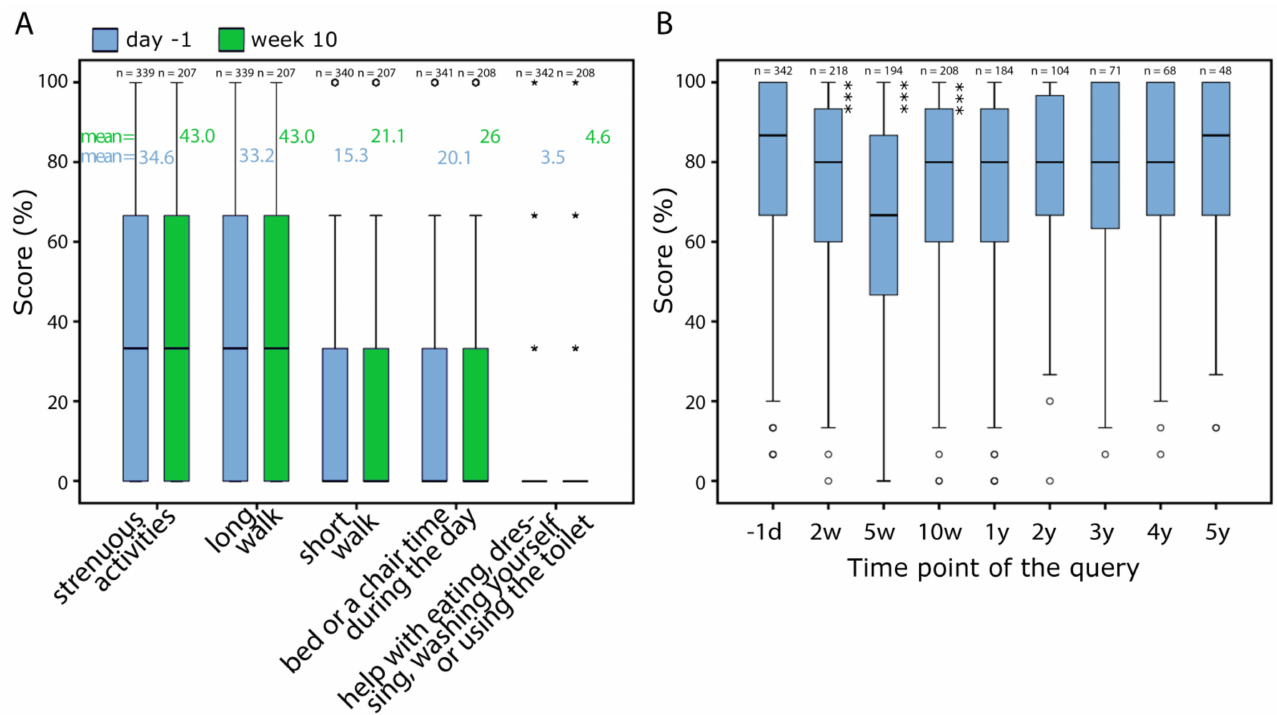
Figure 3. ( A ) Result distribution at day -1 (each left blue bar) and week 10 (each right green bar) for the 5 questionnaire items constructing “physical function”. ( B ) Result distribution of “physical function” at all dates. “ ◦ ” marks outliers and “*” marks extreme